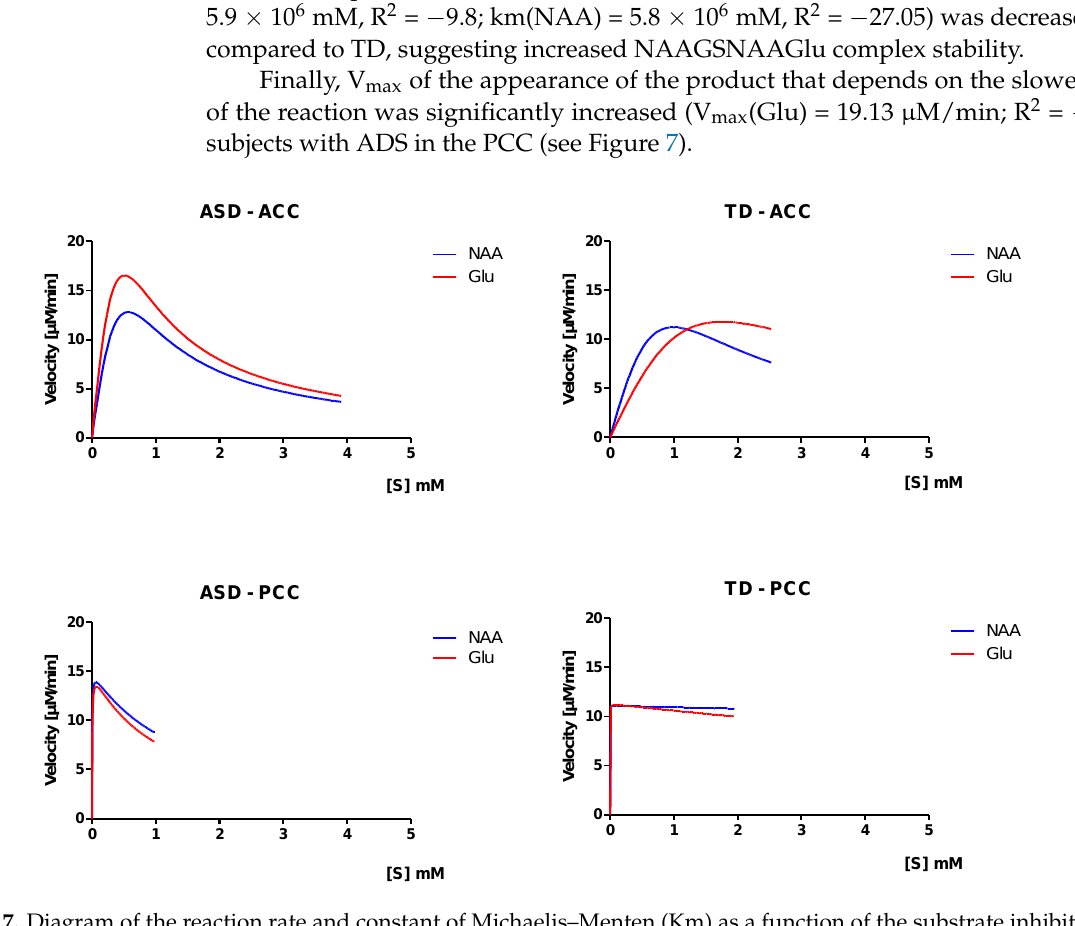
Figure 7. Diagram of the reaction rate and constant of Michaelis–Menten (Km) as a function of the substrate inhibition in N -Acetylaspartyl-glutamate enzyme kinetics. p < 0.05 considered significantly different. (ASD: n = 22; TD: n = 43).